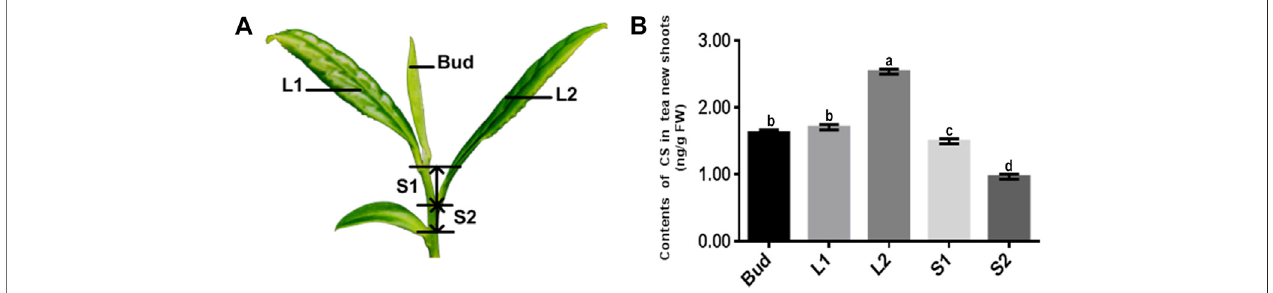
FIGURE 2 | The content of CS in different tissues of new shoots in tea plants. (A) Bud, leaf, and stem samples were collected from top to bottom, named bud, L1, L2, S1,and S2. (B) ContentofCSin fi vetissuesofteatree ’ snewshoots.Datavaluesarethemean ± SDofthreeindependent biologicalsamples.Differentlettersabove the bars indicate signi fi cantly different values ( p <